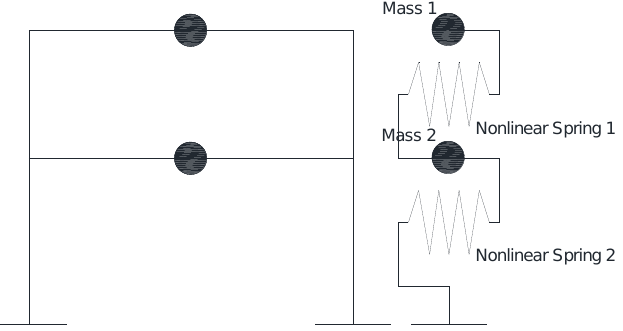
Figure 7. Target structure and analysis model corresponded